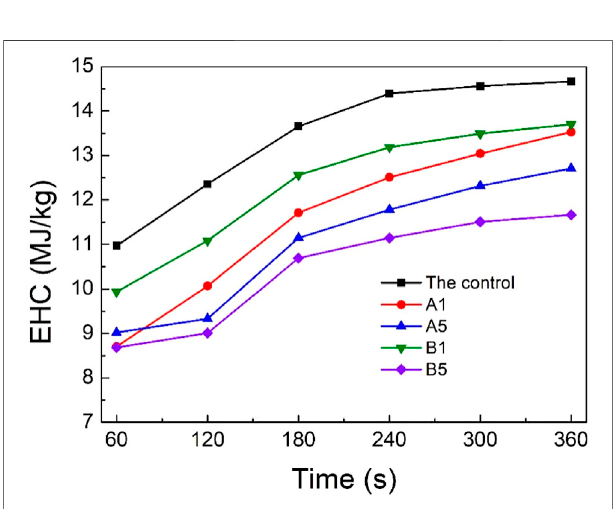
FIGURE 8 | EHC of bamboo specimens before and after LbL self- assembly with PA-PEI in initial 360 s.